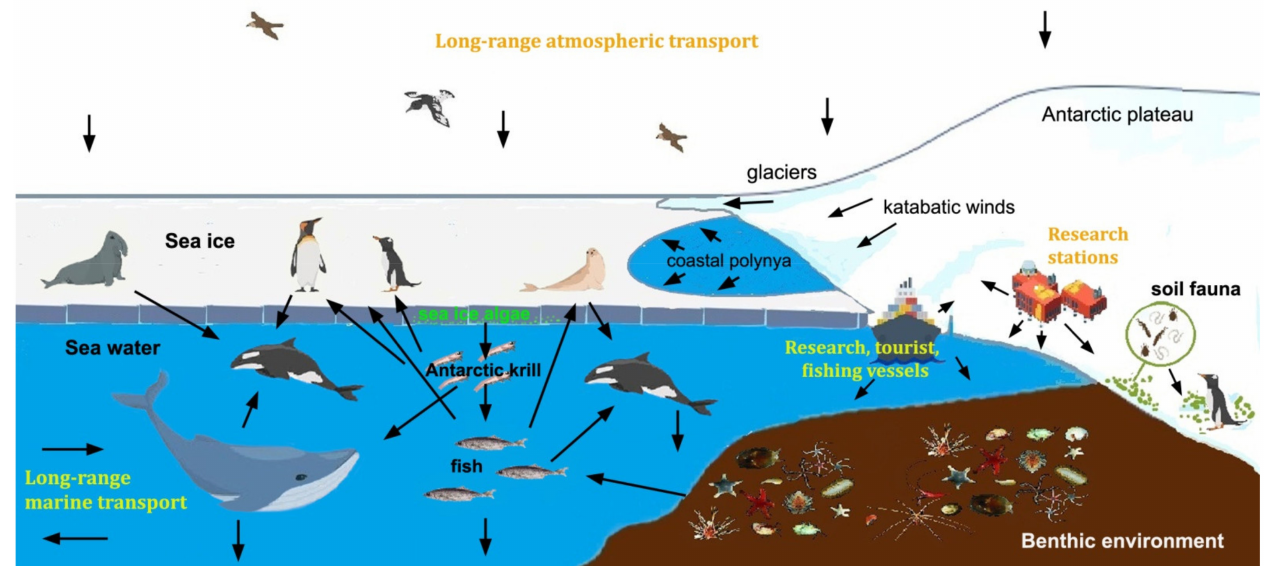
Figure 1. Sources, routes and fate of microplastics in the Antarctic